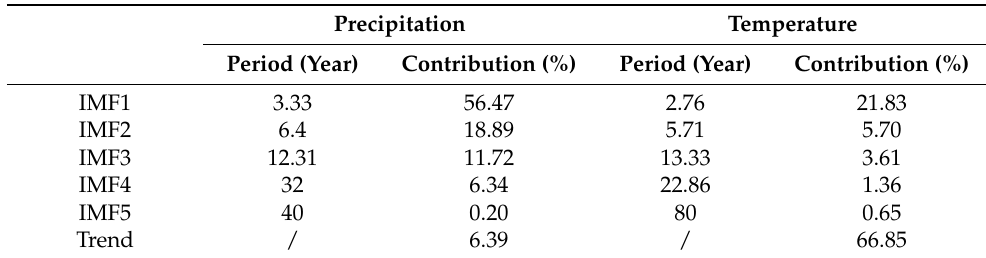
Figure 4. Variation trends of precipitation ( a ) and temperature ( b ) after EEMD. The interannual time scale dominates the precipitation change, with a total variance contribution of 75.36%, including quasi-three-year cycle (IMF1) and quasi-six-year cycle (IMF2). The variance contribution rates are 56.47% and 18.89%, respectively. While there is a quasi-12-year cycle (IMF3) on decadal time scale, with a variance contribution rate of 11.72%. However, the multi-decadal time scale and overall trend are not obvious, and the variance contribution rates are only 6.54% and 6.39%, respectively (Table 3). Different from precipitation, the long-term variation dominates the temperature change, which reflects the sustained global warming caused by a large number of greenhouse gas emissions for a long time, with the variance contribution rate reaching 66.85%. In addition, the interannual variation in the quasi-three-year cycle is also notable (IMF1), with a contribution rate of 21.83%, while the total contribution of multi-decadal variation is only 2.01% (Table 3). Table 3. Variance contribution rates and periods of precipitation and temperature components after